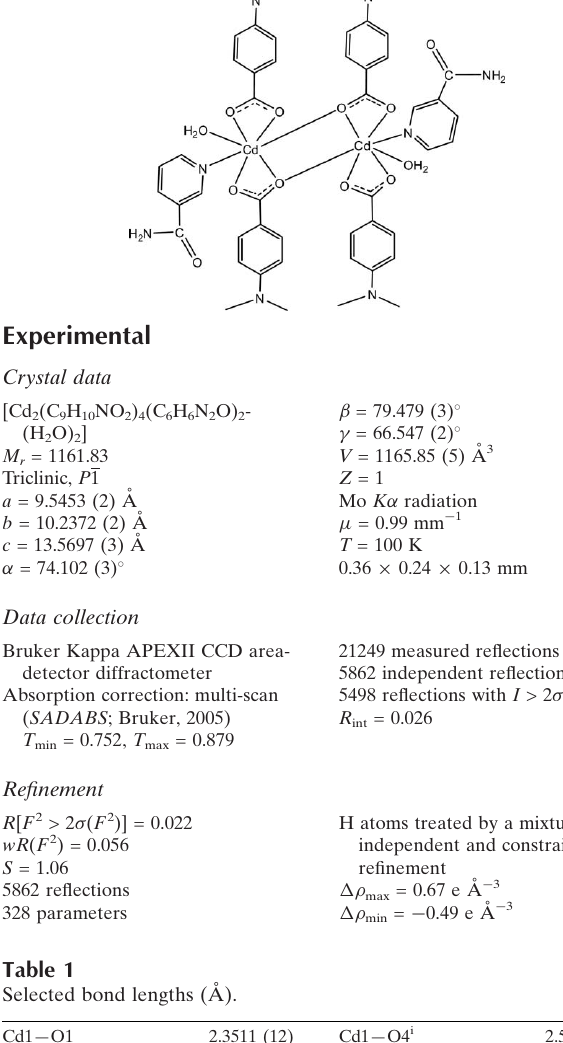
Selected bond lengths (A˚ ).